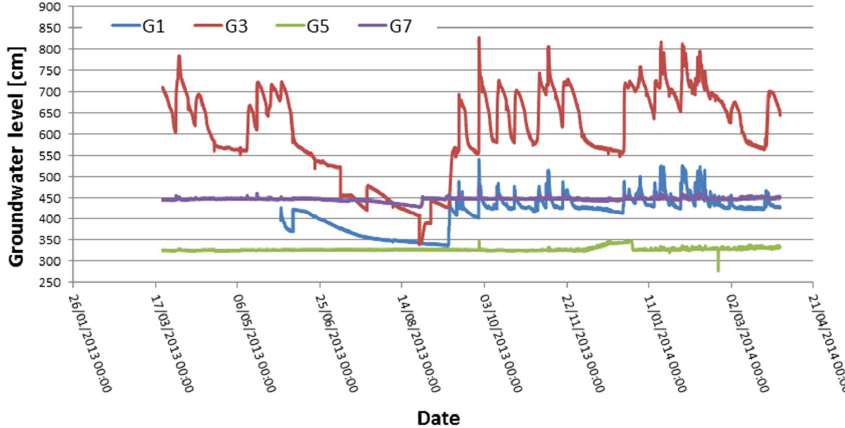
Figure 6. Groundwater-level oscillation at the Grohovo landslide (Žic et al.,